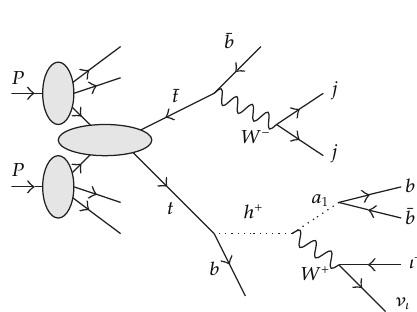
Figure 4: Illustrations of tt production in proton-proton collisions with the subsequent decay chain considered in this